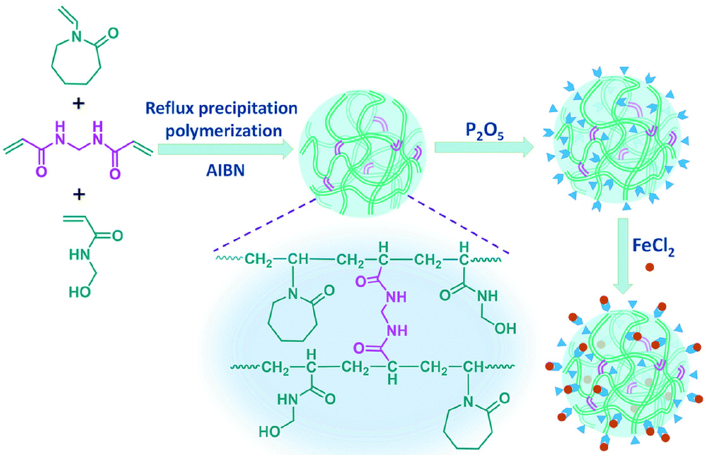
Figure 4. The synthetic scheme of the iron nanozymes based on poly( N -vinyl caprolactam) (PVCL). Reprinted with permission from Ref. [76]. Copyright 2020 Royal Society of Chemistry.